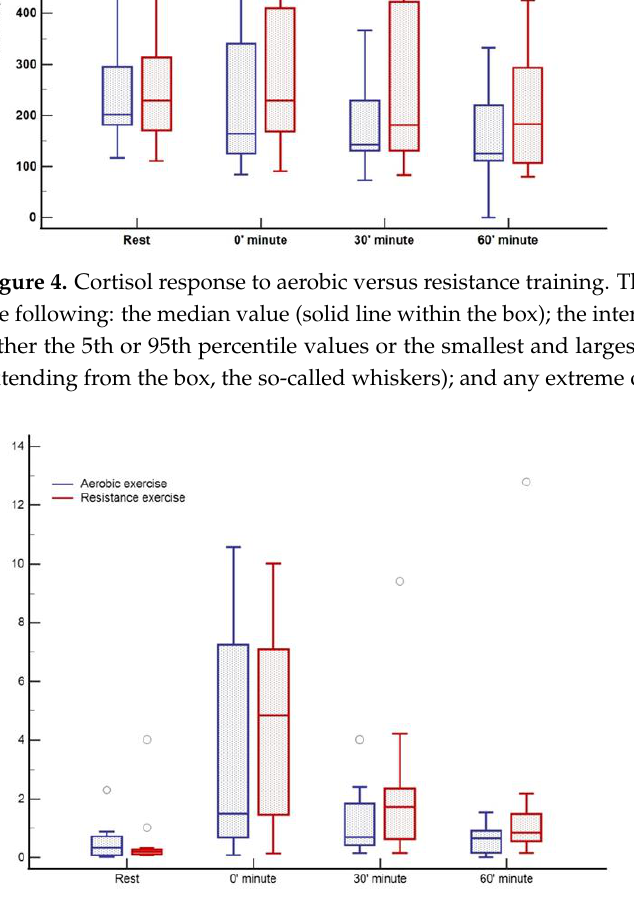
Figure 5. GH response to aerobic versus resistance training. The circles represent the extreme outliers.